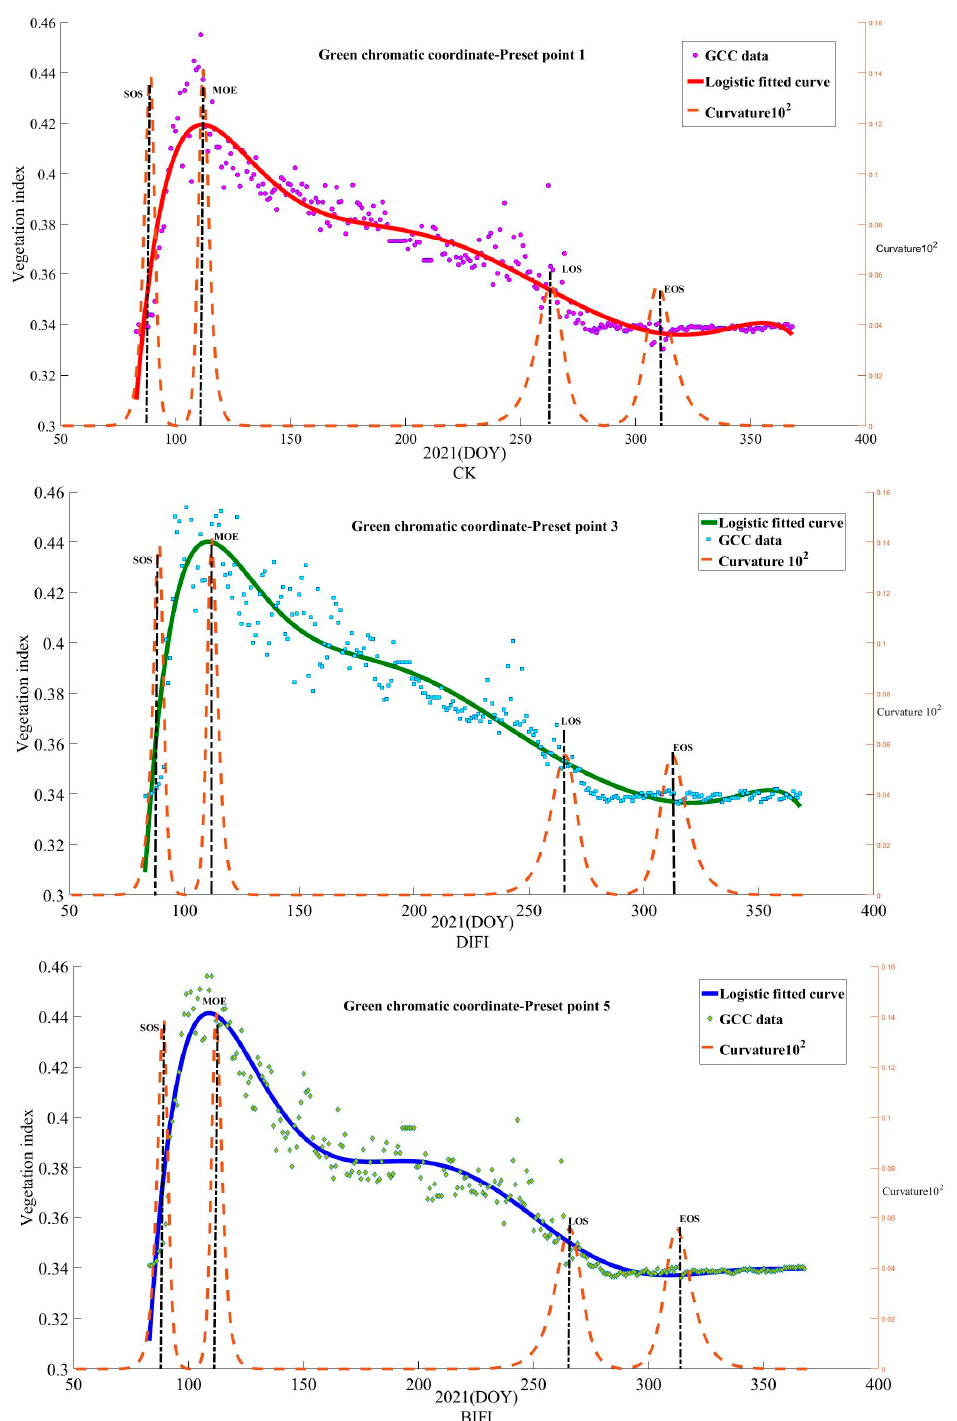
Figure 11. Growth curve fitting and key phenological period extraction at different preset points.